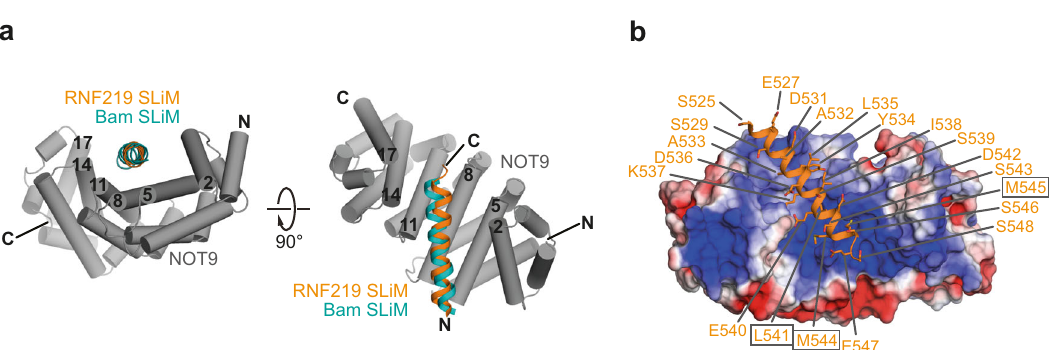
Fig. 5 Structure prediction of the RNF219 SLiM in complex with NOT9. a AlphaFold2-predicted structure of the RNF219 SLiM (orange cartoon) bound to NOT9 (gray) shown in two orientations. NOT9 helices are depicted as tubes and are numbered in black. The Dm Bam SLiM (cyan cartoon) is superposed on RNF219. b Electrostatic surface potential (with red representing negatively charged patches and blue positive ones) plotted onto the molecular surface of NOT9. The predicted bound RNF219 SLiM is shown as a cartoon (orange) with side chains of residues in stick representation. Visible residues are indicated with labels and residues substituted for glutamic acid are indicated